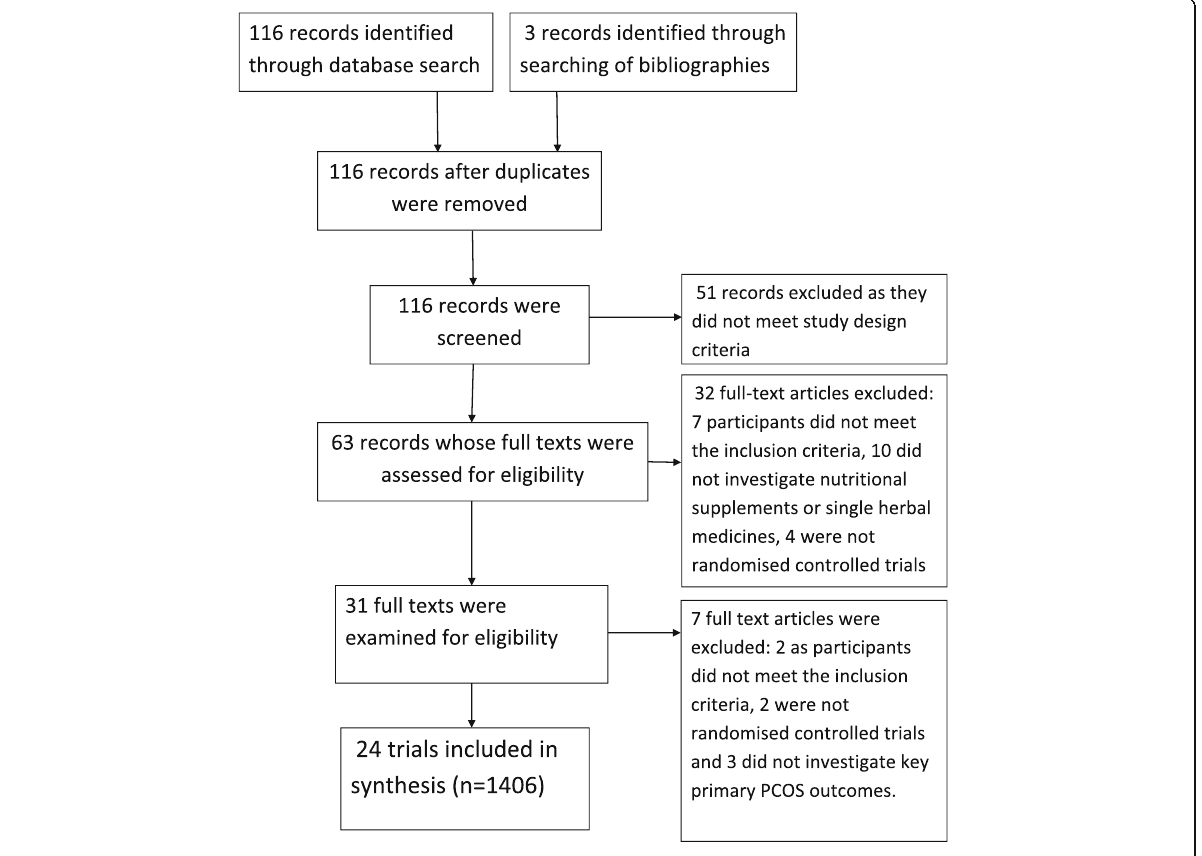
Fig. 1 PRISMA (flow chart)